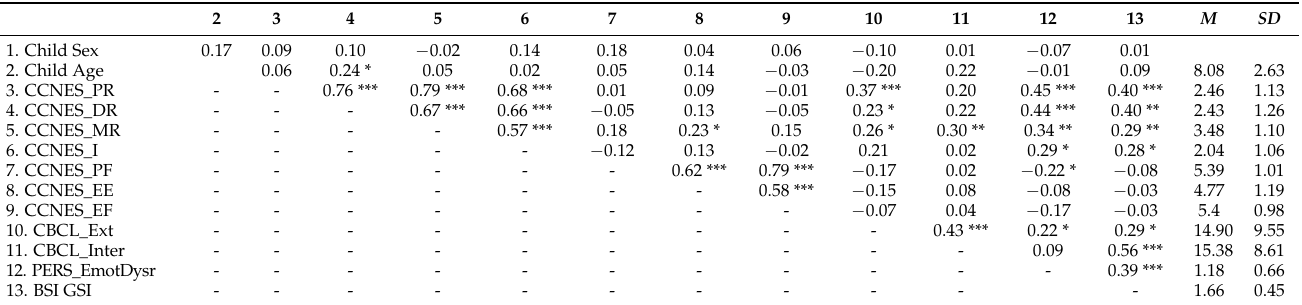
Table 1. Descriptive statistics and bivariate correlations between the study